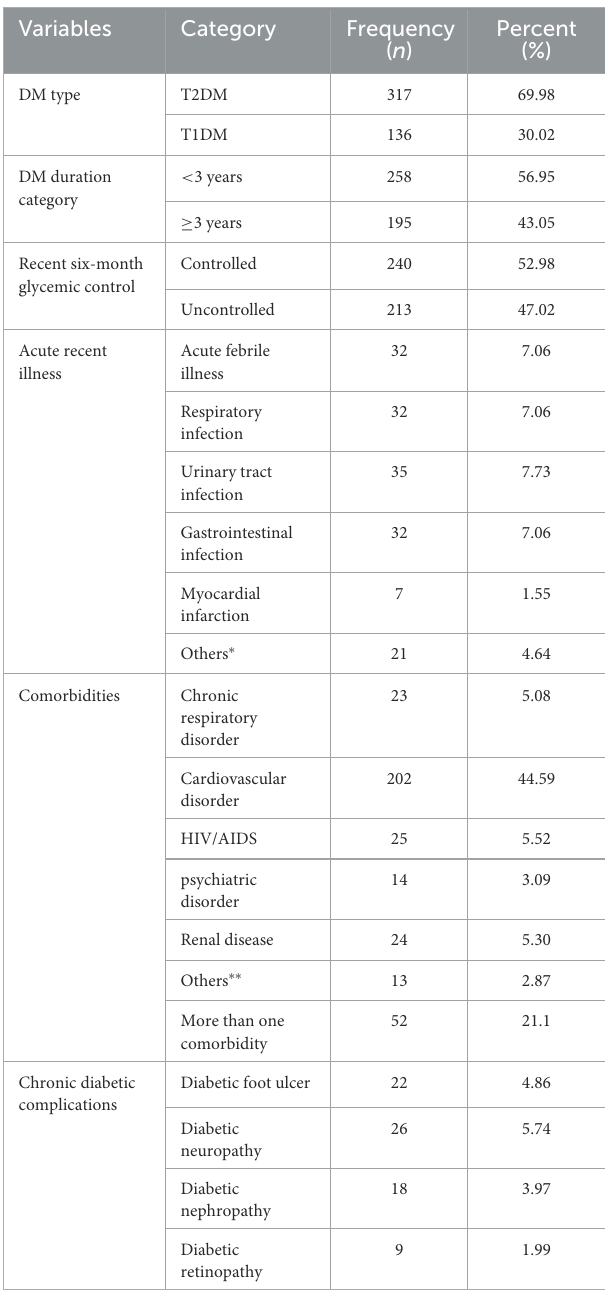
TABLE 2 Clinical-related results of adult patients with diabetes in Bahir Dar public hospitals, North West Ethiopia, 2021 ( n =